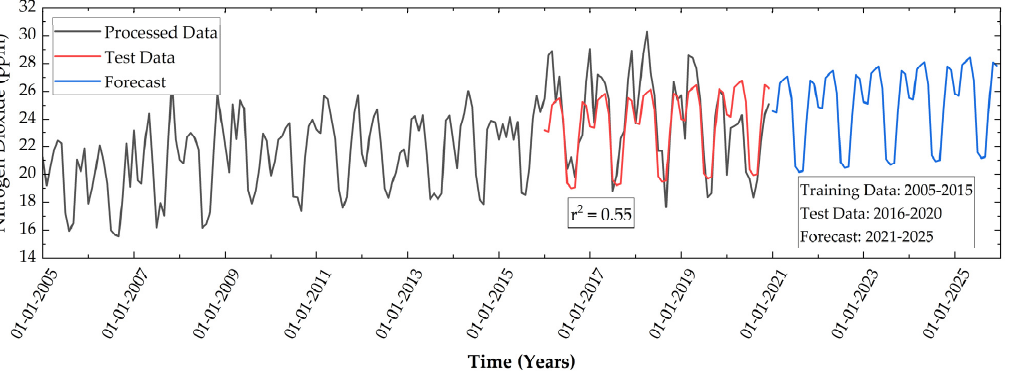
Figure 8. Temporal variations of monthly mean NO 2 in the study area from 2005 to 2020 and forecast during 2021–2022 using linear regression.